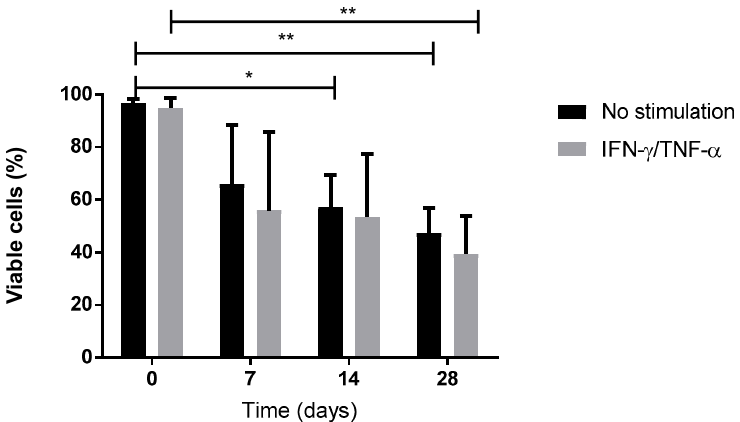
Figure 3. Cell viability for stimulated (IFN- γ and TNF- α ) or unstimulated MSCs (day 0) and chondro-MSCs during 28 days of culture in Alg / HA hydrogels. Data are expressed as mean ± SD ( N = 4 independent cords). * p < 0.05 and ** p < 0.01.